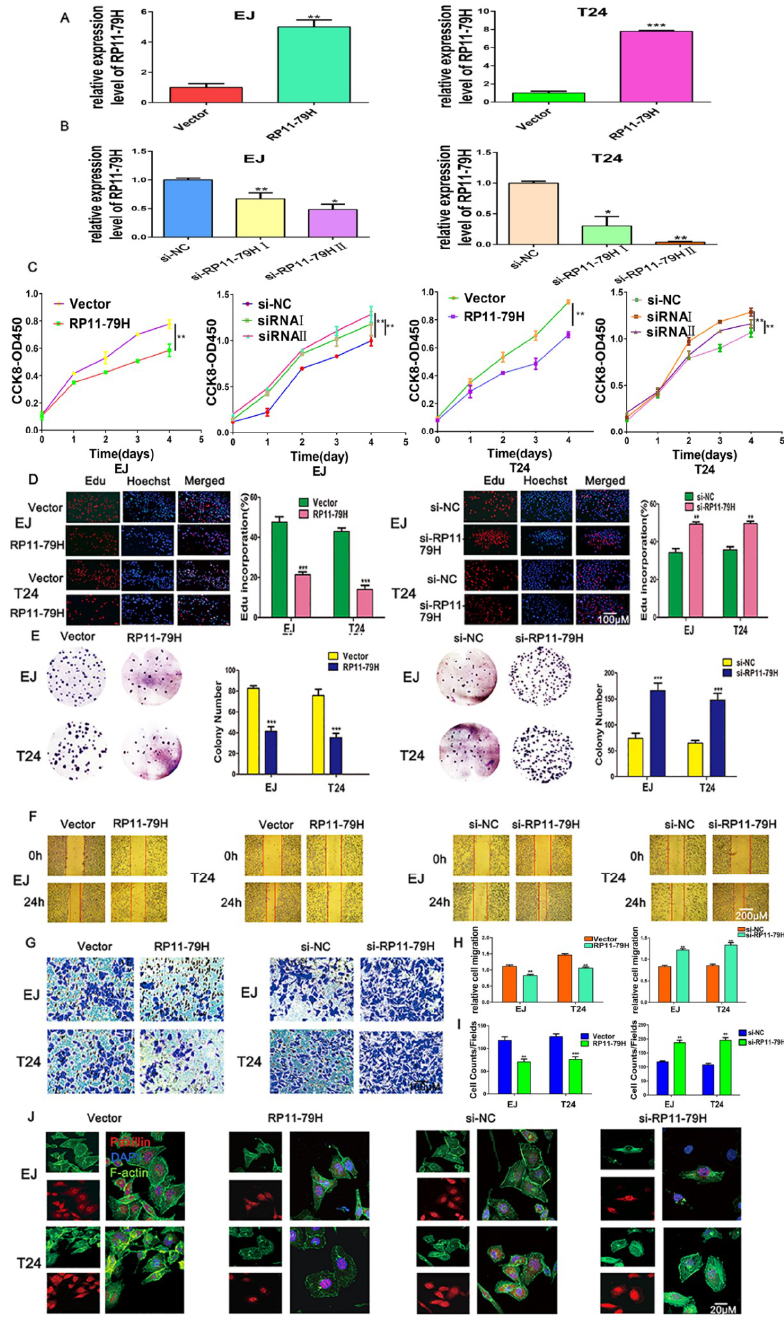
Figure 2. RP11-79H23.3 influences BC cell proliferation, migration, and invasion in vitro. ( A , B ) The expressions of RP11-79H23.3 was detected in BC cells transfected with pIRES2-RP11-79H23.3 or si-RNA fragments (si-RP11-79H23.3I, si-RP11-79H23.3II) by qRT-PCR. ( C – E ) The cell proliferation ability was assessed by CCK-8, EdU, and colony formation assays after upregulation and downregulation of RP11-79H23.3 in EJ and T24 cells. CCK-8 cell growth curve, relative quantification of EdU-incorporating cells, and soft agar colony formation numbers are shown, respectively (scale bar, 100 µ m). ( F , G ) The cell migration and invasion capacities were detected in upregulating or downregulating RP11-79H23.3 cells by wound healing and transwell assays (scale bar, 200 µ m; scale bar, 100 µ m. ( H , I ) Quantitative analyses of wound healing and transwell assay are shown. Each experiment was independently repeated at least three times. Data is shown as mean ± SD. ( J ) Cytoskeleton was surveyed by phalloidine-FITC staining of microfilament and immunofluorescence staining for paxillion in BC cells under confocal laser scanning microscopy when RP11-79H23.3 was upregulated or downregulated (scale bar, 20 µ m). * p < 0.05; ** p < 0.01; *** p <